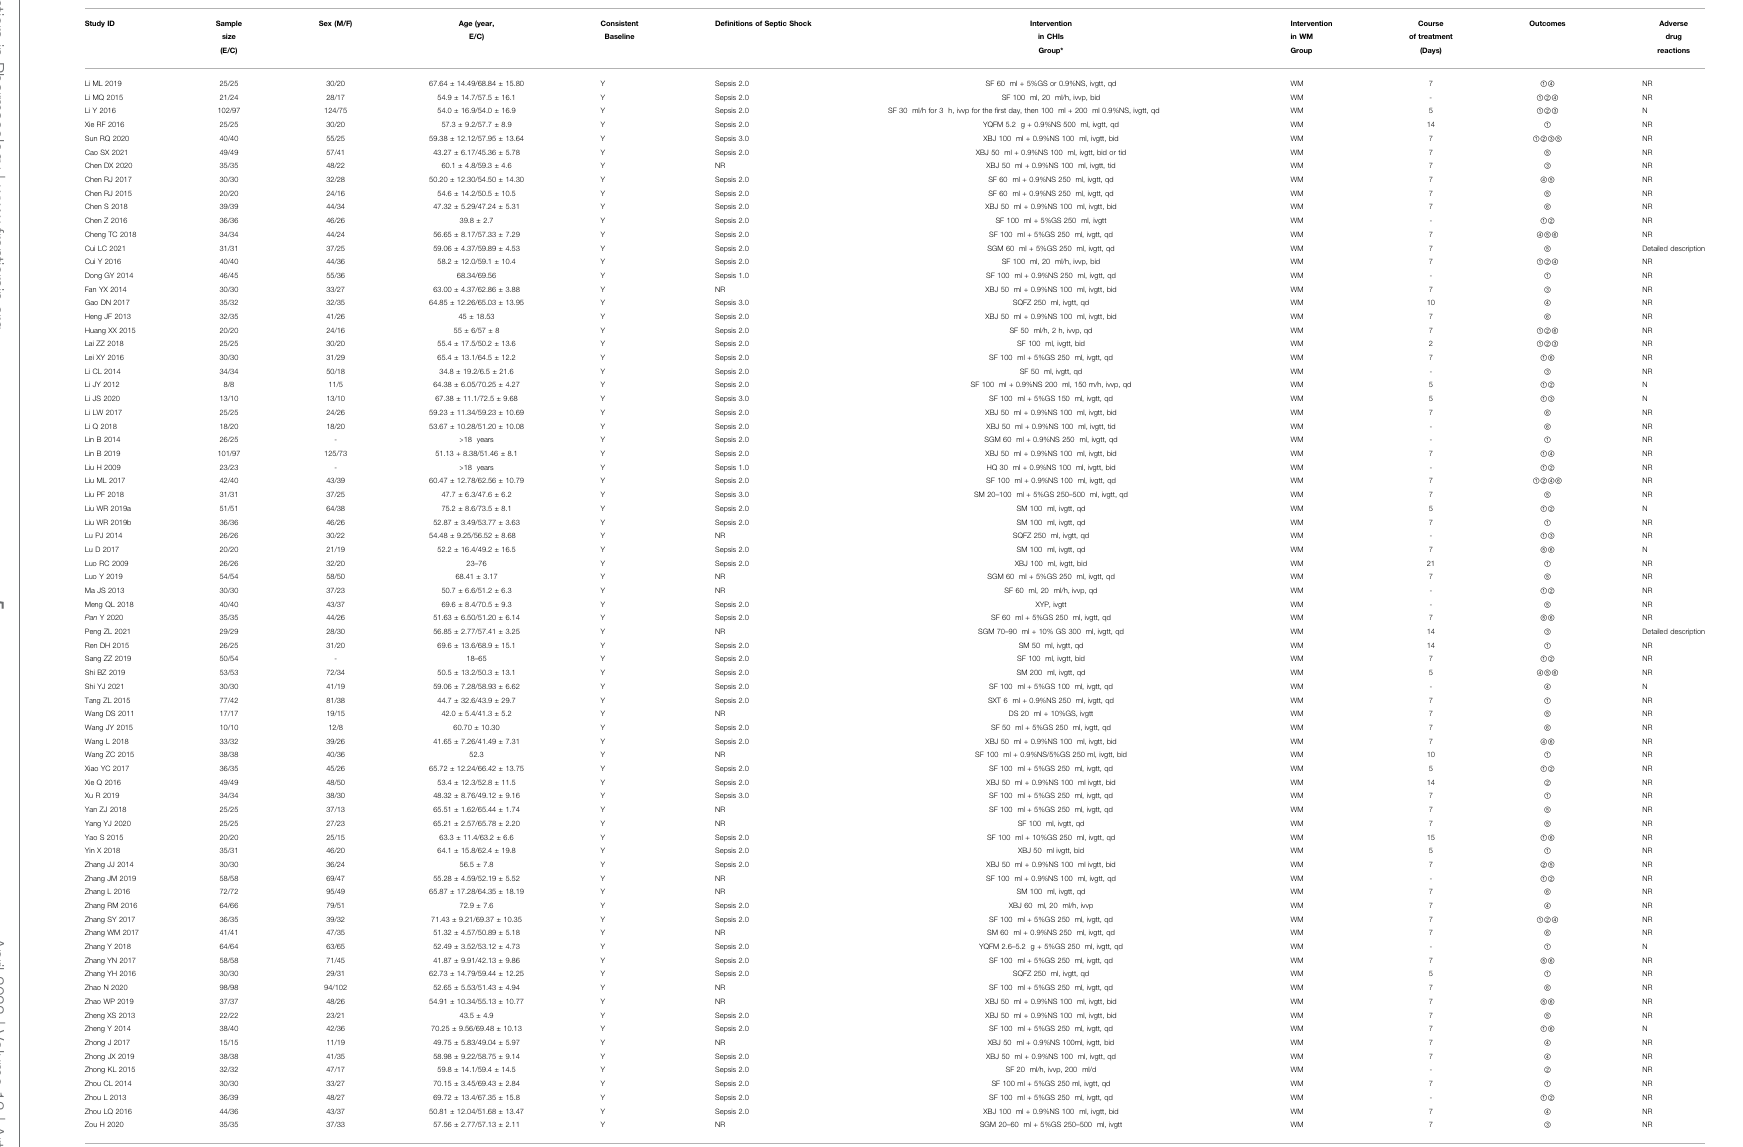
TABLE 1 | Characteristics of the included